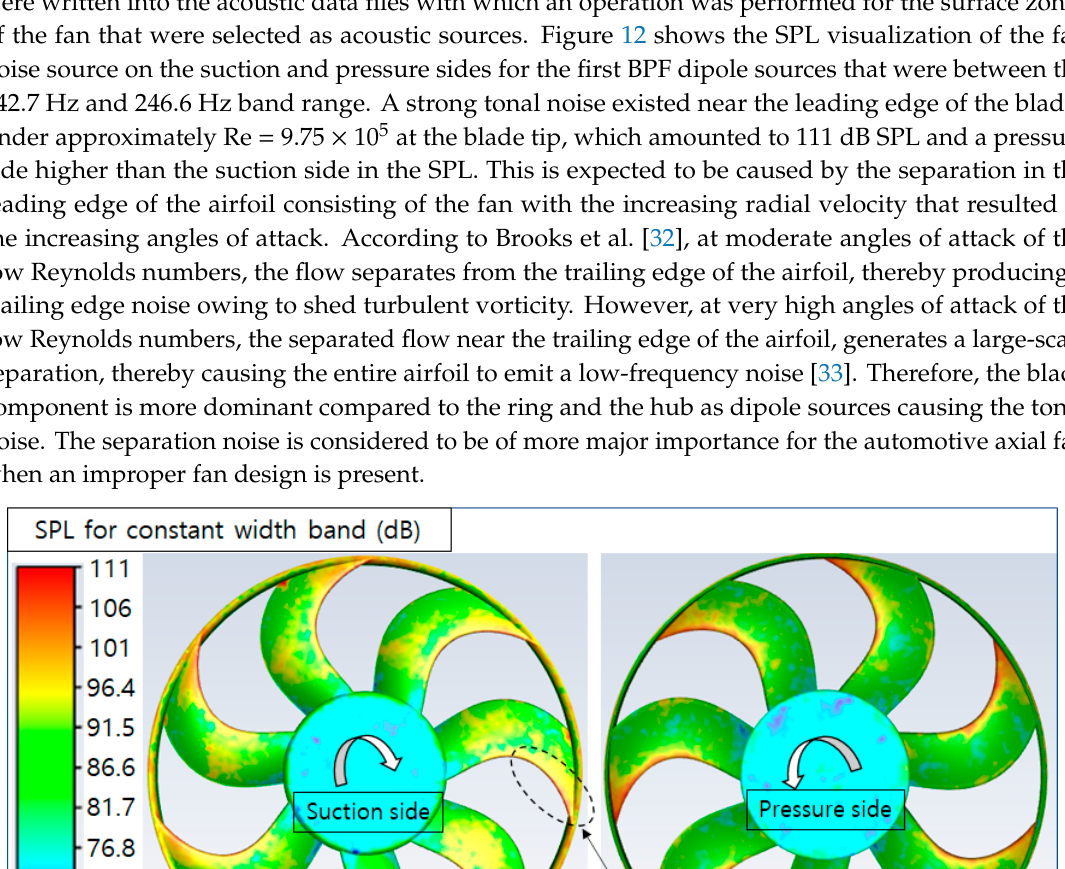
Figure 12. SPL visualization of the fan noise source on the suction ( left ) and pressure ( right ) sides between 242.7 Hz and 246.6 Hz band range .